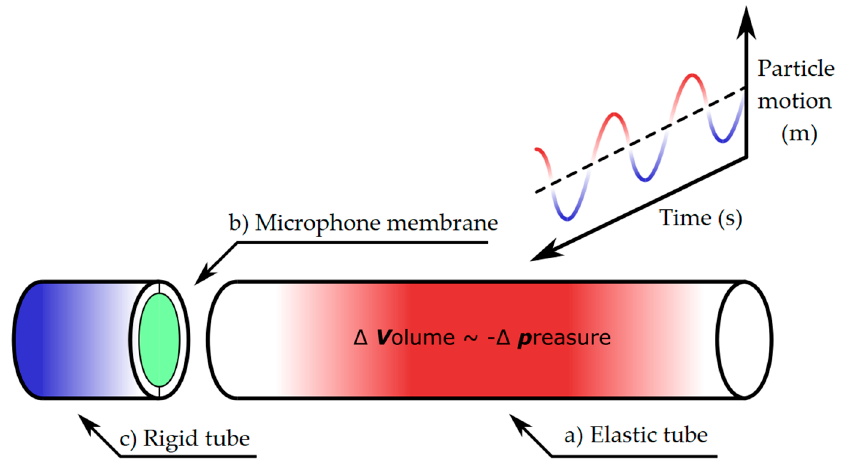
Figure 7. The basic principle of acoustic sensor operation.